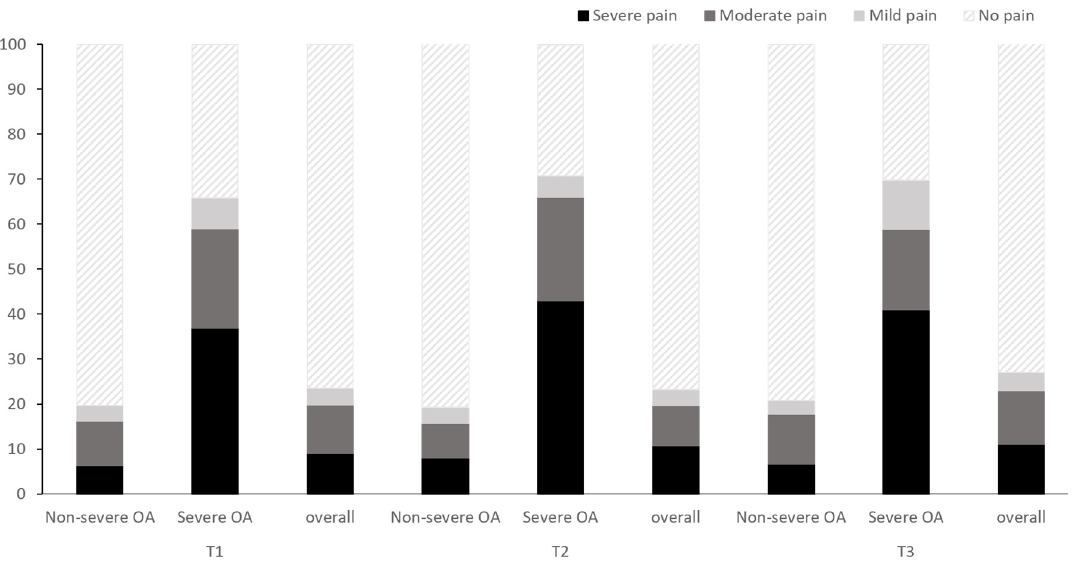
Figure 3. Percentage of knee pain scale scores according to the tertiles of log-transformed ALP levels. Abbreviations: ALP, alkaline phosphatase; OA, osteoarthritis.